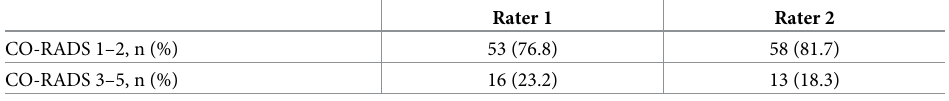
Table 2. Interrater agreement for the evaluation of COVID-19 lung involvement in neck computed tomography